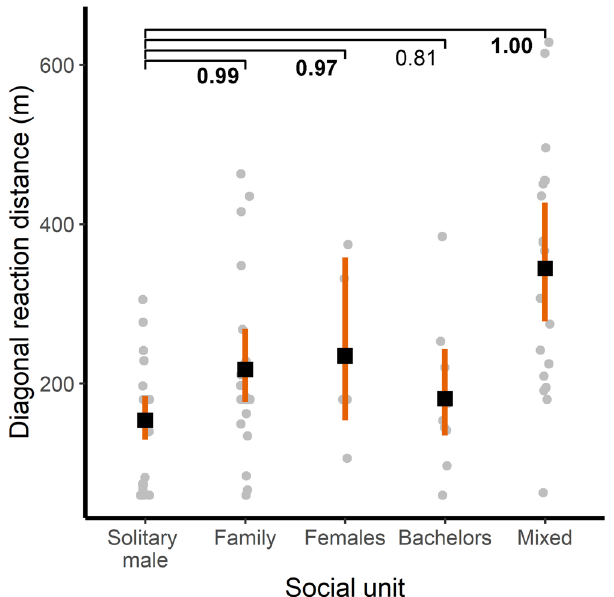
Figure 4. Diagonal reaction distance (rz) and type of social unit during experimental drone flights. Black squares represent predicted mean estimates of the models; orange vertical bars represent the 95% CrI. Grey dots represent raw data, horizontally jittered. Numbers represent the posterior probability of a mean difference between compared estimates. A statistically meaningful effect (presented in bold) can be assumed when the posterior probability of the mean difference between compared estimates is higher than